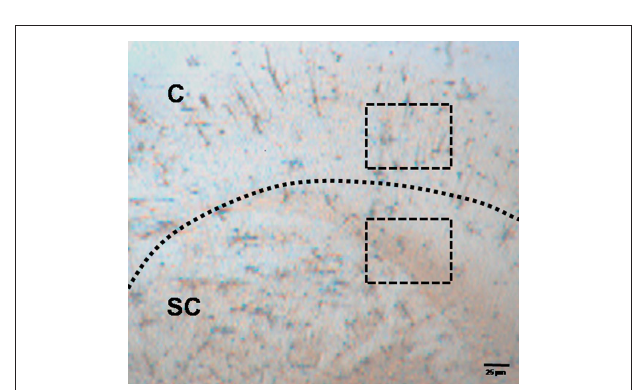
FIGure 3 | Photomicrograph ( × 20) of Golgi–Cox stained section prepared from a block incubated for 24 h at 37 ± 1 ° C. Dashed line defines the boundary between Cortical (C) and sub-cortical (SC) zones. Stained neurons were counted within randomly selected rectangular areas as shown in the figure and explained in the